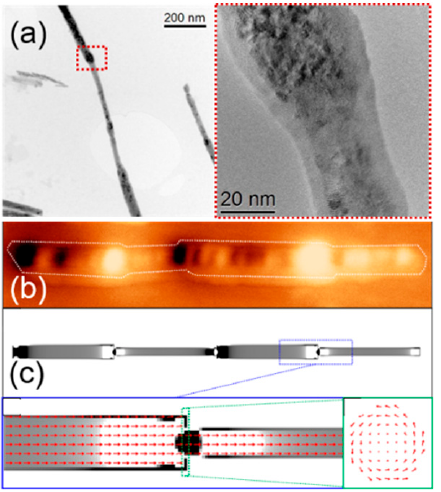
Figure 6. ( a )-(left), HRTEM images of a modulated nanowire, (right), a close-up image of the area highlighted with a red square in ( a )-(left). ( b ) MFM image of an isolated FeCoCu modulated nanowire ( c ) Simulated configuration at remanence for a modulated wire with two thick and two thin parts, equivalent to the experimental case. Adapted with permission from ref. [24]. Copyright 2015 IOP Publishing Ltd.